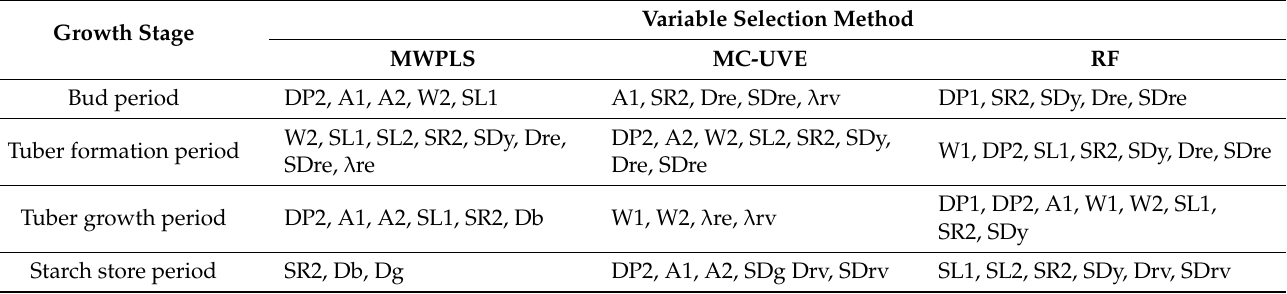
Table 3. Location parameters of AGB estimation model selected by MWPLS, MC-UVE, and RF methods for each potato growth